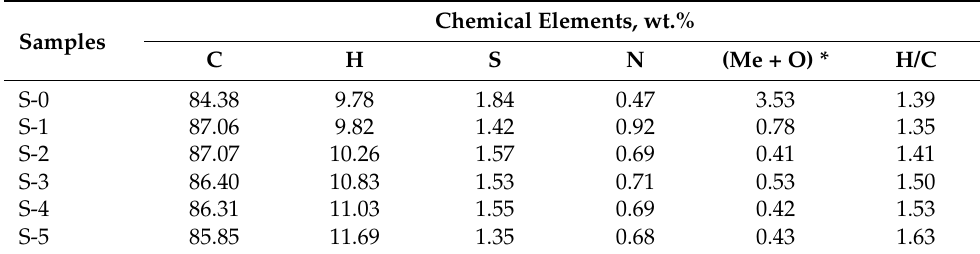
Table 1. Results of elemental composition of initial and upgraded